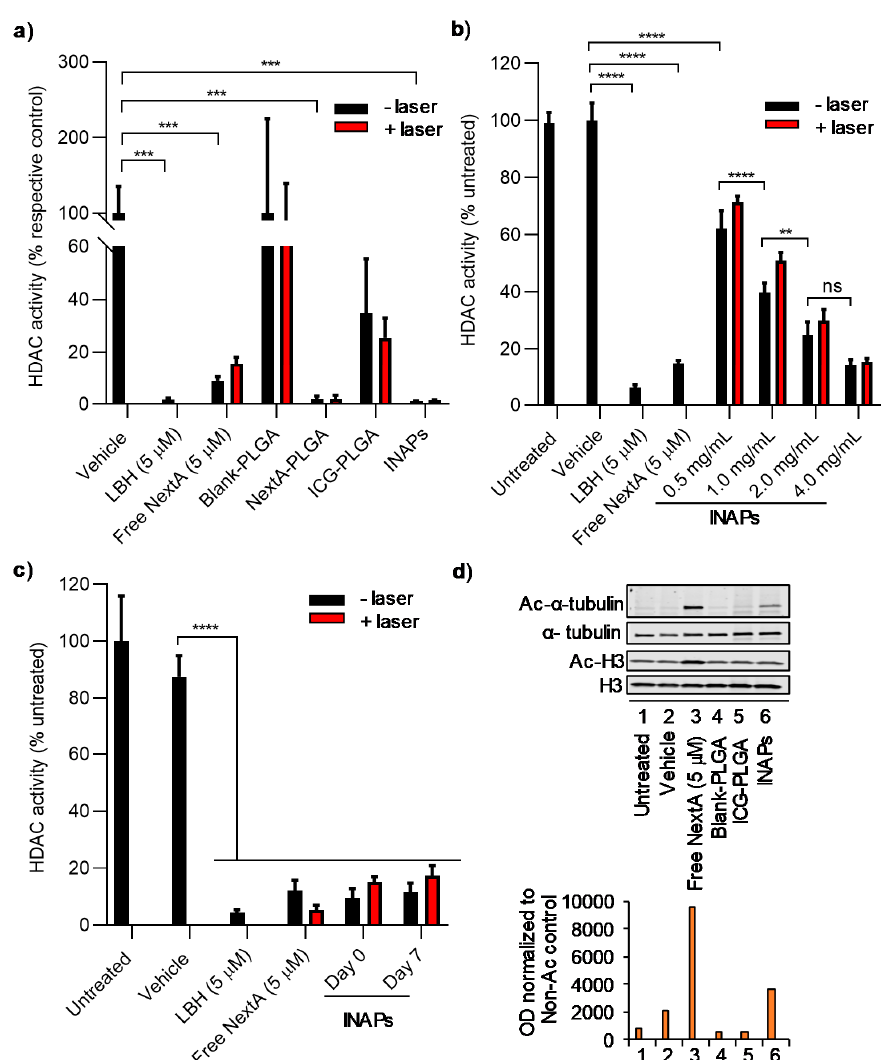
Figure 4. Inhibition of HDAC activity in melanoma cells in vitro by NextA encapsulated within INAPs. ( a ) HDAC activity of SM1 melanoma cells in vitro measured by a luminescence reporter assay when treated with INAPs, ICG-PLGA, NextA-PLGA, Blank-PLGA, free NextA, a positive control (panobinostat; LBH), and vehicle in the absence (black) and presence (red) of the NIR laser at 0.8 W for 5 min. HDAC activity decreased after treating with INAPs, NextA-PLGA, free NextA, and LBH. *** p -value < 0.001. ( b ) HDAC activity (luminescence) of B16F10 melanoma cells in vitro treated with varying concentrations of INAPs (0.5–4 mg / mL) and controls in the absence (black) and presence (red) of the NIR laser at 0.8 W for 5 min showed concentration-dependent HDAC inhibition. ns (not signficiant), ** p -value < 0.01, **** p -value < 0.0001. ( c ) HDAC activity (luminescence) of B16F10 melanoma cells in vitro treated with freshly synthesized (Day 0) or short-term stored INAPs (Day 7) and controls in the absence (black) and presence (red) of the NIR laser at 0.8 W for 5 min demonstrated functionally active NextA in INAPs after storage. **** p -value < 0.0001. ( d ) Expression levels of Ac- α -tubulin, α -tubulin, and acetylated histone 3 (Ac-H3) and histone 3 (H3) in B16F10 melanoma cells treated with INAPs and controls in vitro demonstrated increased Ac- α -tubulin expression after NextA and INAPs treatment. Top panel: Western blot image of the various treatment groups, bottom panel: Image analysis of the expression levels in the top panel (using Image J, National Institutes of Health, Bethesda, MD, USA).